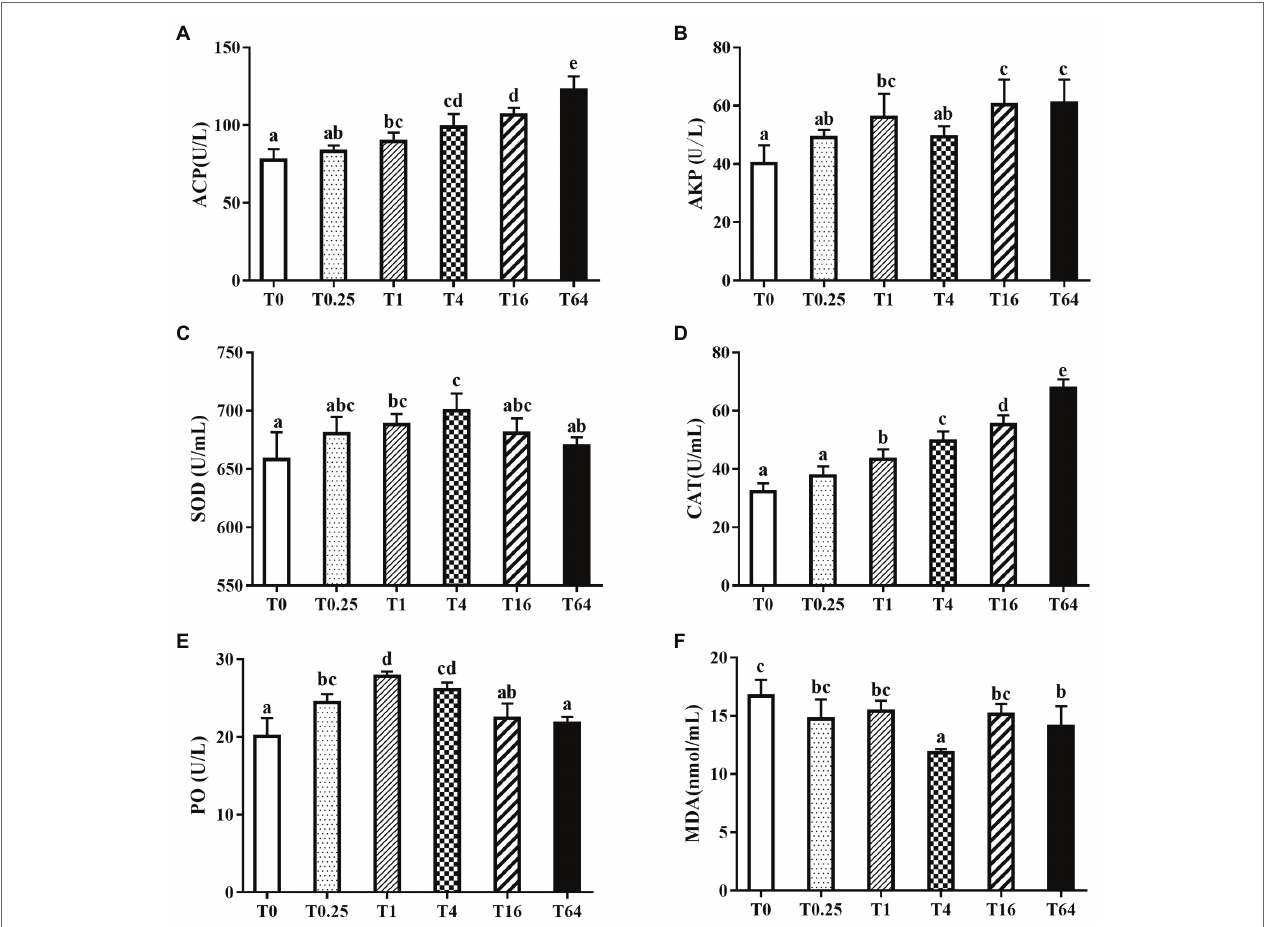
FIGURE 3 | Effects of dietary TWS119 on non-specific immune indices of P. vannamei . The activities of ACP (A) , AKP (B) , SOD (C) , CAT (D) and PO (E) , and the content of MDA (F) in the haemolymph were measured. Values (means ± SD) in bars that have the different letters represent significantly different ( p < 0.05; Tukey’s test) among treatments ( n = 3).